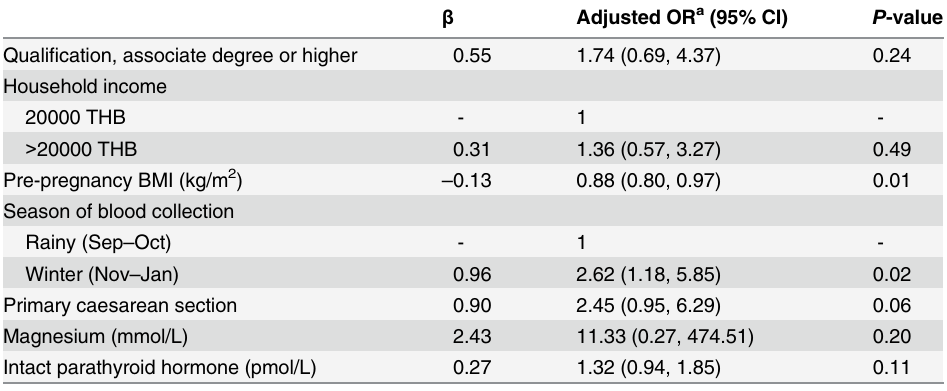
Table 3. Multivariate analysis of factors associated with a plasma level of 25-hydroxyvitamin D < 50 nmol/L (n = 147).